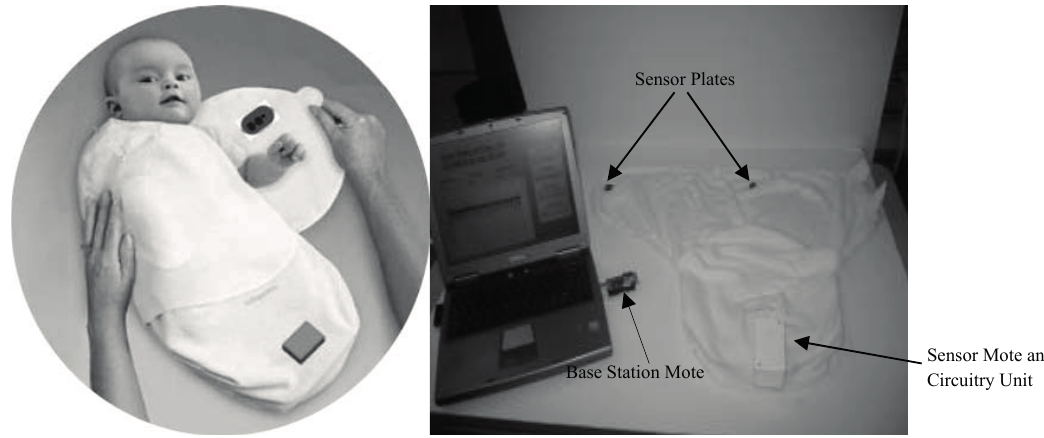
Figure 13. Baby glove swaddle ( left ) and the basic setup ( right ) [23]. Copyright © 2007 IEEE.